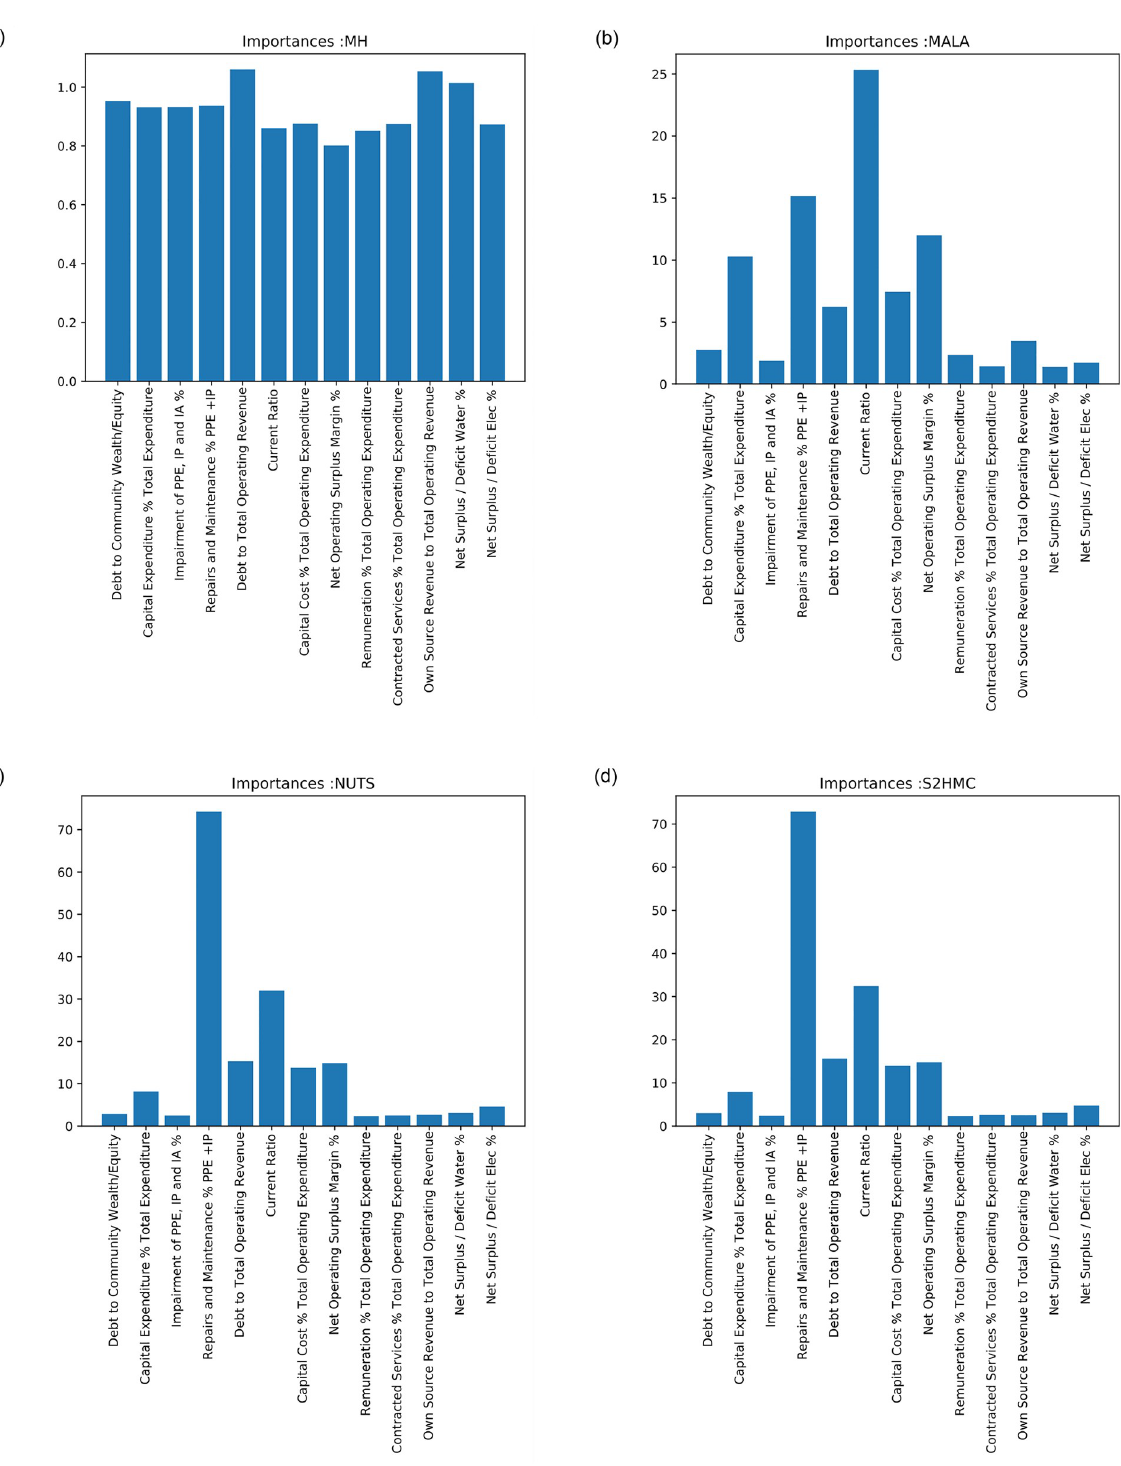
PLOS ONE | https://doi.org/10.1371/journal.pone.0261245 December14,